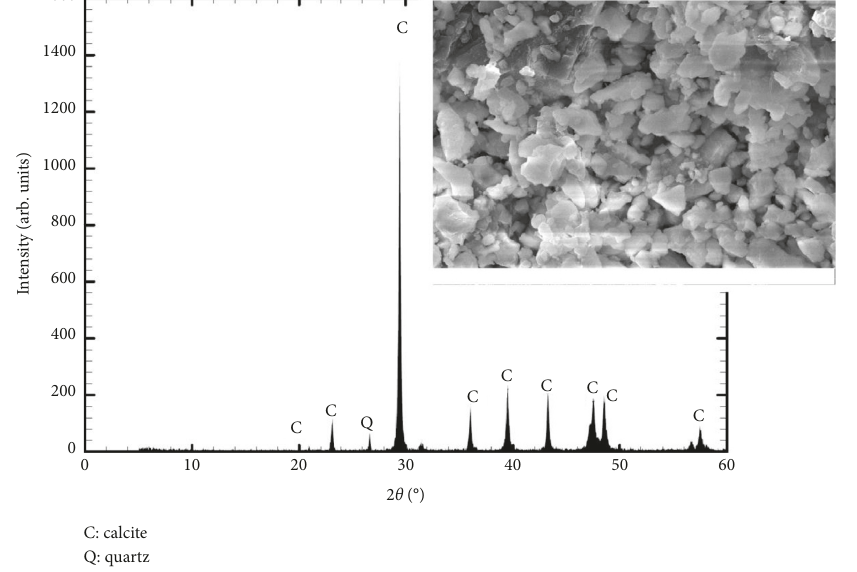
Figure 8: SEM micrographs and XRD patterns of marble powder